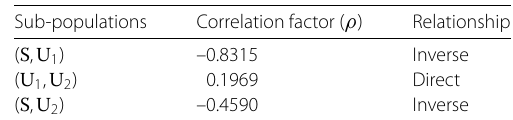
Table 3 Covariance of